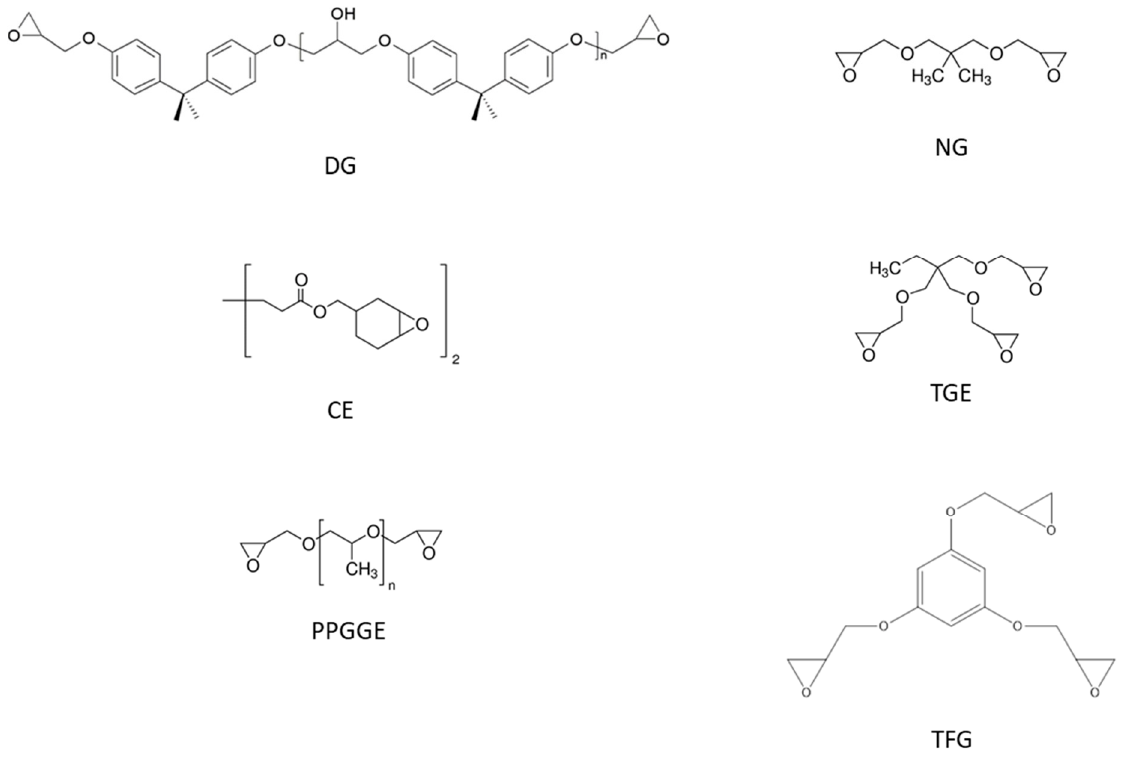
Figure 6. Different epoxides employed. For complete names, see Section 2.